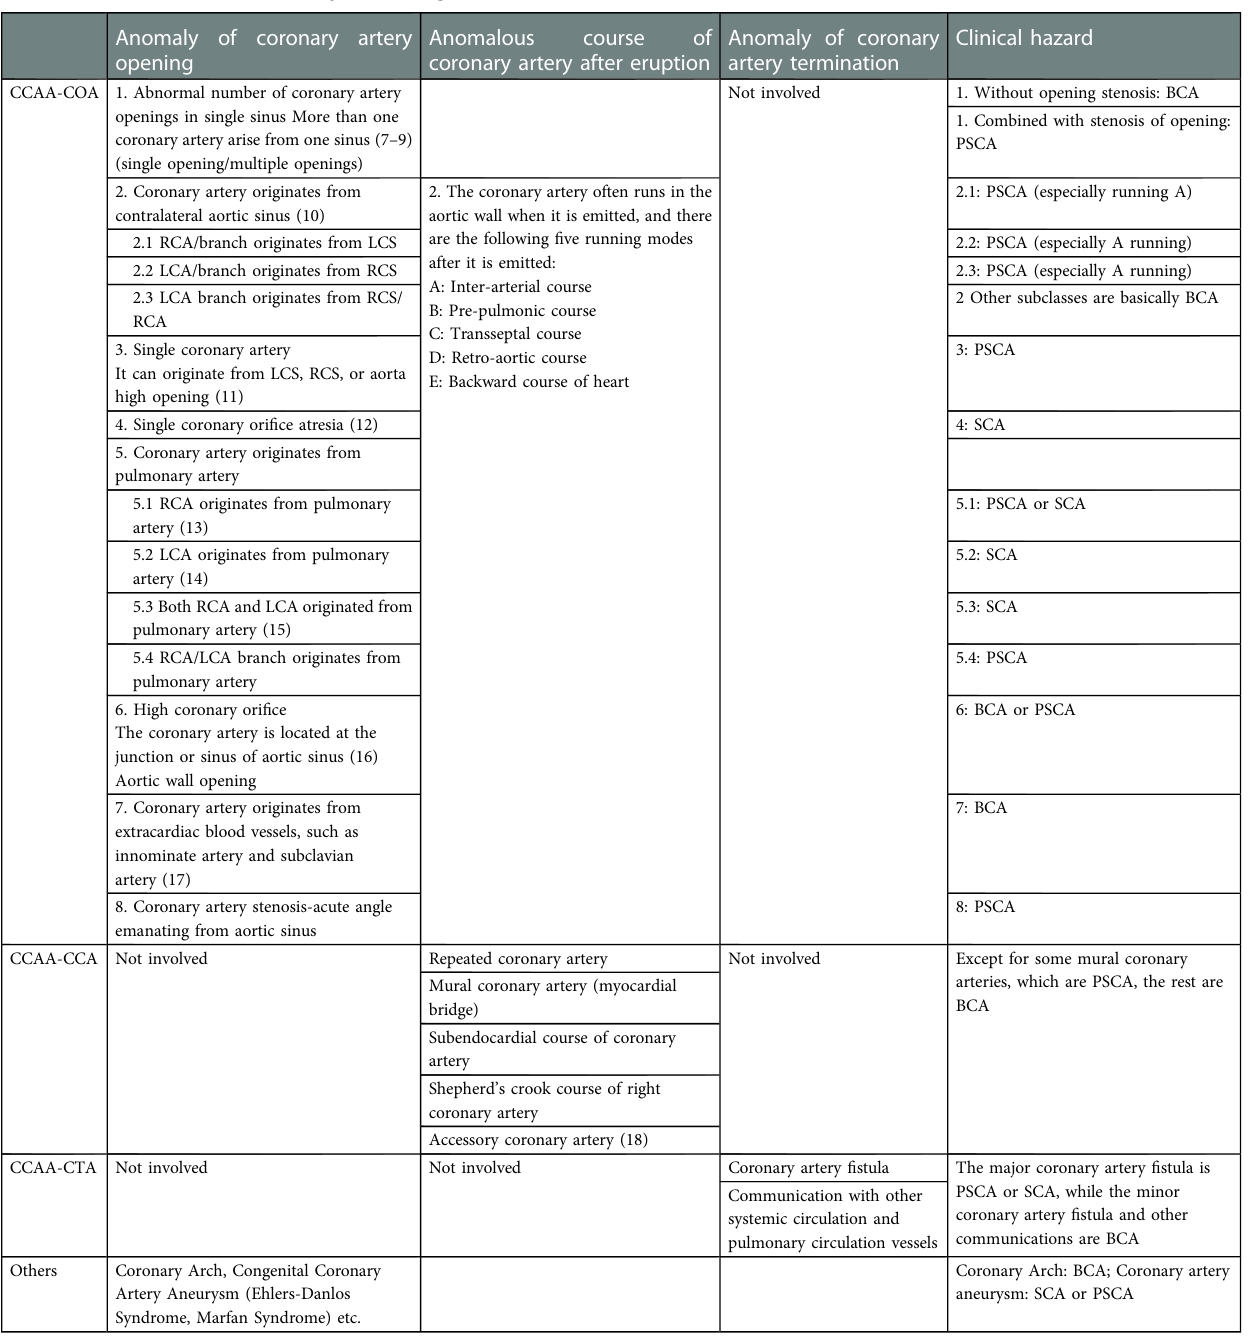
TABLE 2 Classi fi cation of CCAA anatomy and risk